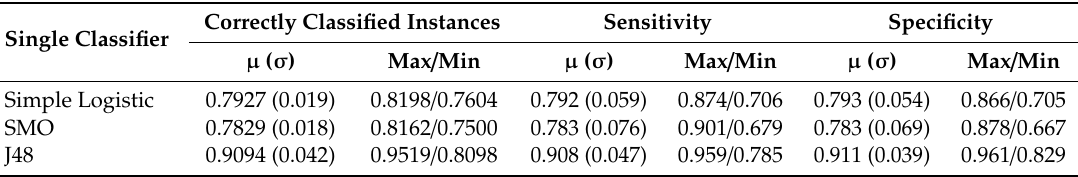
Table 3. Comparison of the prediction results of di ff erent model for RA.